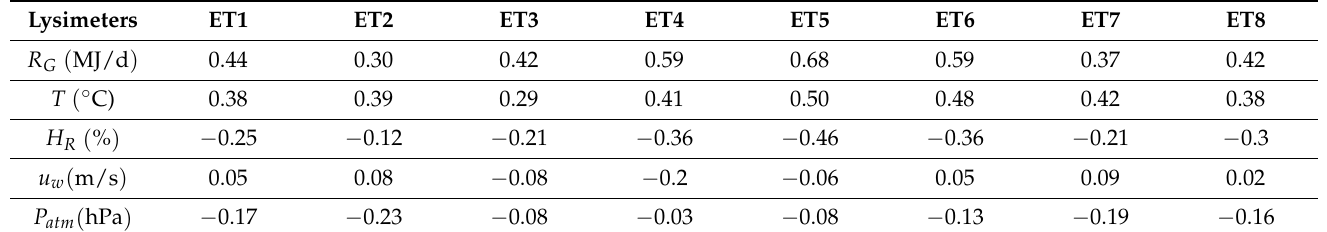
Table 6. Linear correlation coefficients (Pearson) between estimated evapotranspiration (ET) and measured meteorological variables.